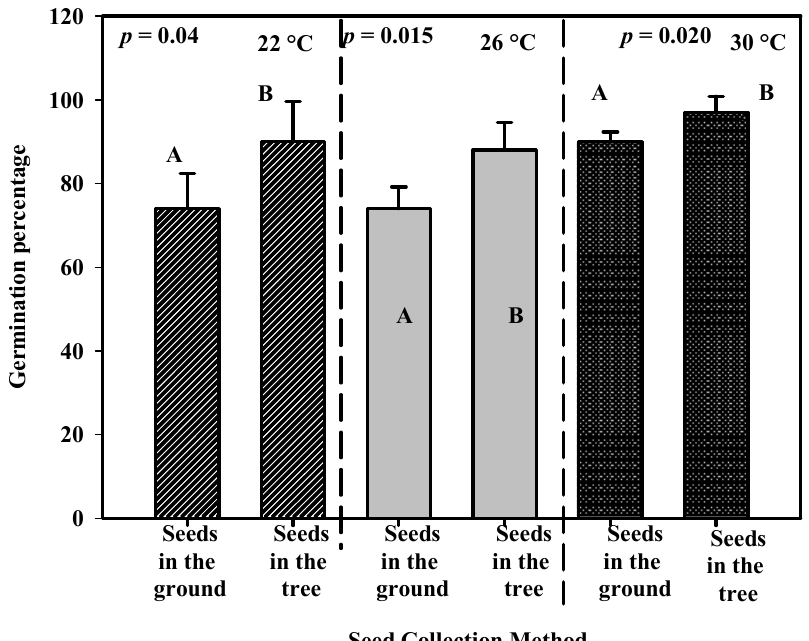
Figure 7. T-test results for the germination percentage of D. cinnabari seeds collected from the ground and directly from the crown and evaluated for their germination at temperatures of 22 °C, 26 °C, and 30 °C. Means with the same letter are not significantly different from each other ( p = 0.05).